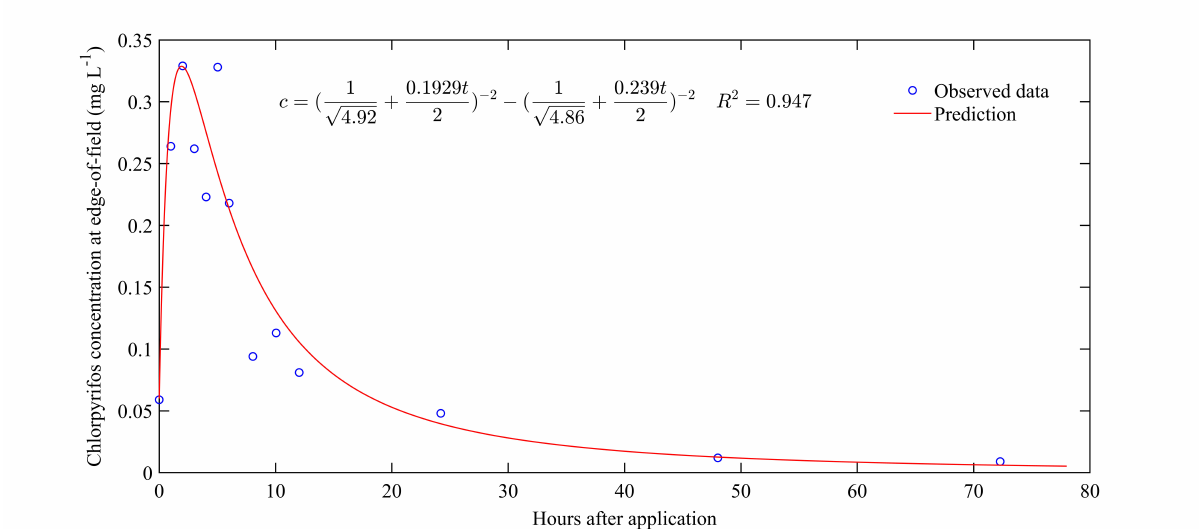
Figure 4. Fitted curve of the combined 1.5–1.5-order kinetic model for the prediction of chlorpyrifos concentration at the outlet of the field ditch adjacent to paddy